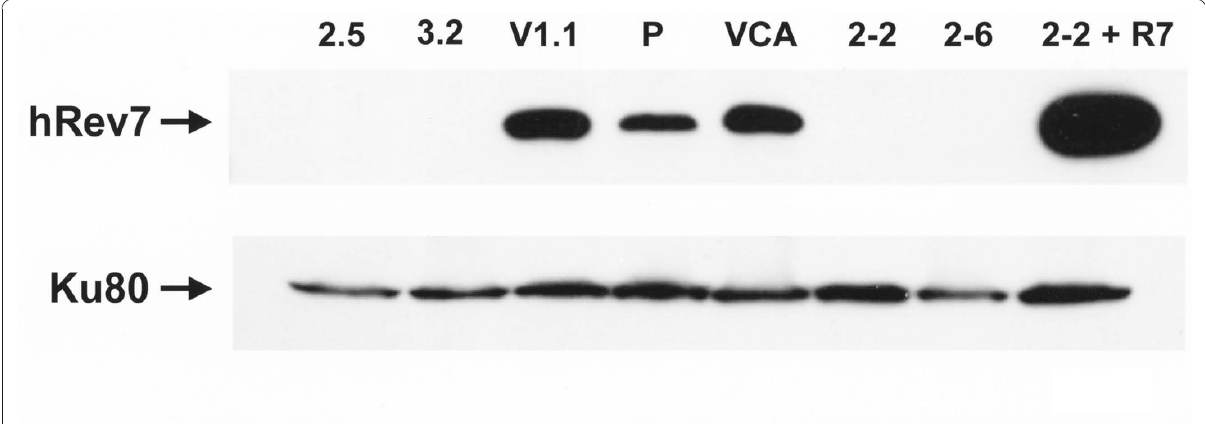
Figure 1 Western blot analysis of the level of hRev7 protein . The level of hRev7 protein was examined by Western blotting of nuclear extracts obtained from the parental cell strain (P), derivative strains expressing hRev7 siRNA (clones 2-2, 2-6, 2.5 and 3.2), control strains expressing an siRNA with limited homology to known sequences in the human genome (VCA and V1.1), as well as a complementation derivative of cell strain 2-2 that expresses an siRNA insensitive hRev7 (2-2 + R7). Ku80 was used as a loading